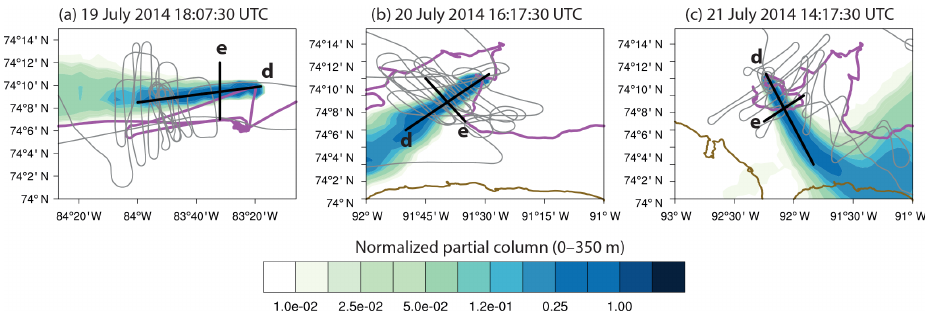
Figure 5. Snapshots of normalized FLEXPART-WRF predicted partial columns (0–350m) indicating the location of the ship (initial location of emitted plume) and the predicted plume location. The flight track is shown in grey and the ship track is shown in magenta. The vertical plume structure is studied in Fig. 7 along the plume (noted by black line, d) and across the plume (noted by black line, e) on each panel. Coastlines are shown in gold.